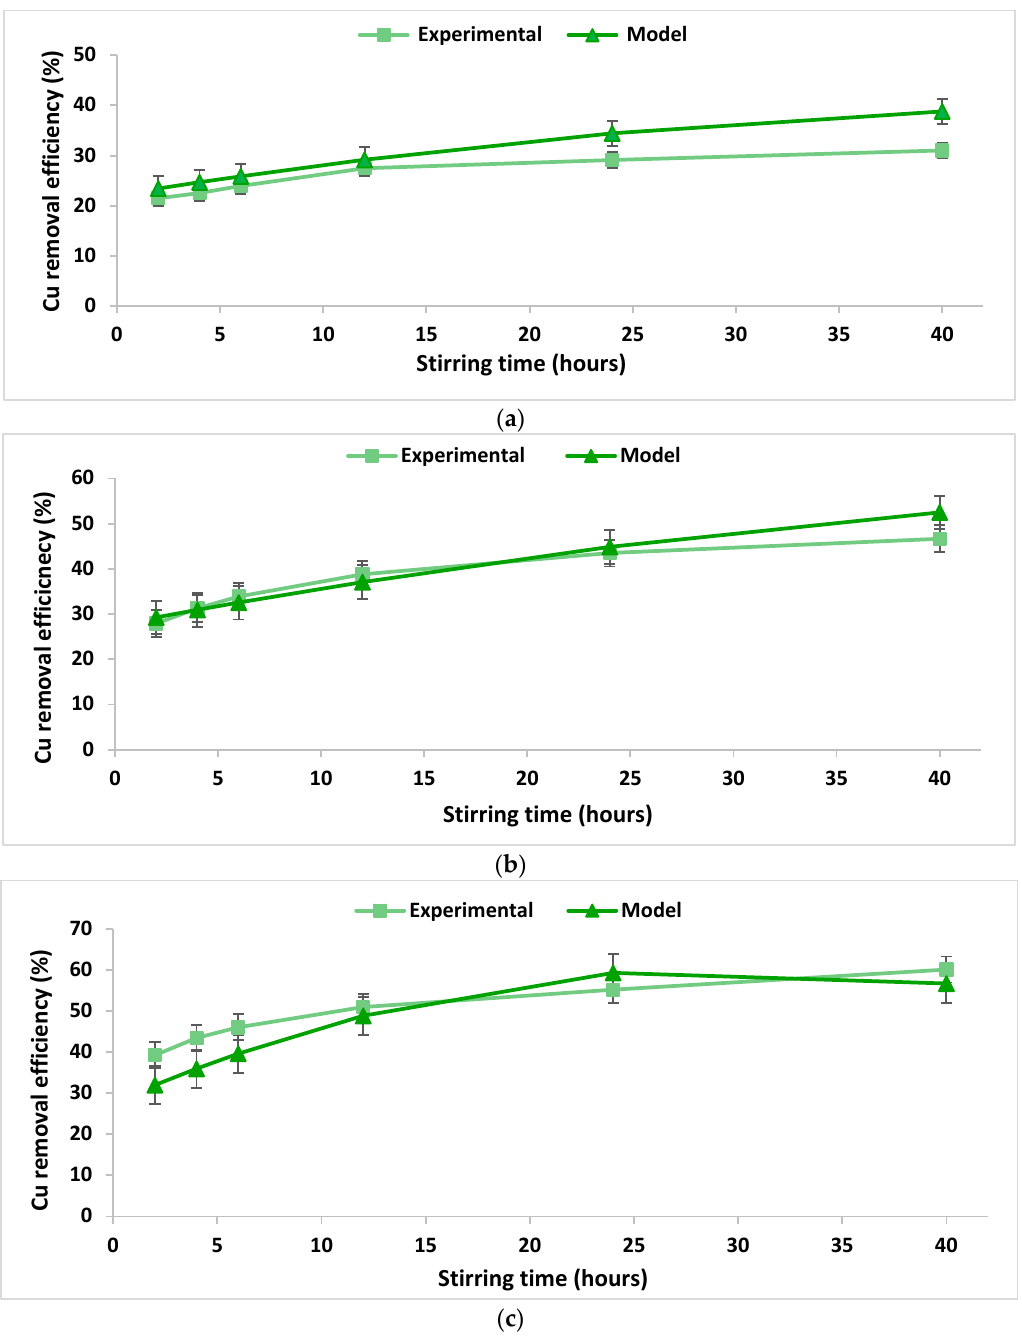
Figure 3. Copper removal efficiency over the stirring time using 2% chitosan washing solution at a S/L ratio of ( a ) 0.2 dec.fr. and ( b ) 0.0625 dec.fr.; copper removal efficiency over the stirring time using 5% chitosan washing solution at a S/L ratio of ( c ) 0.125 dec.fr.